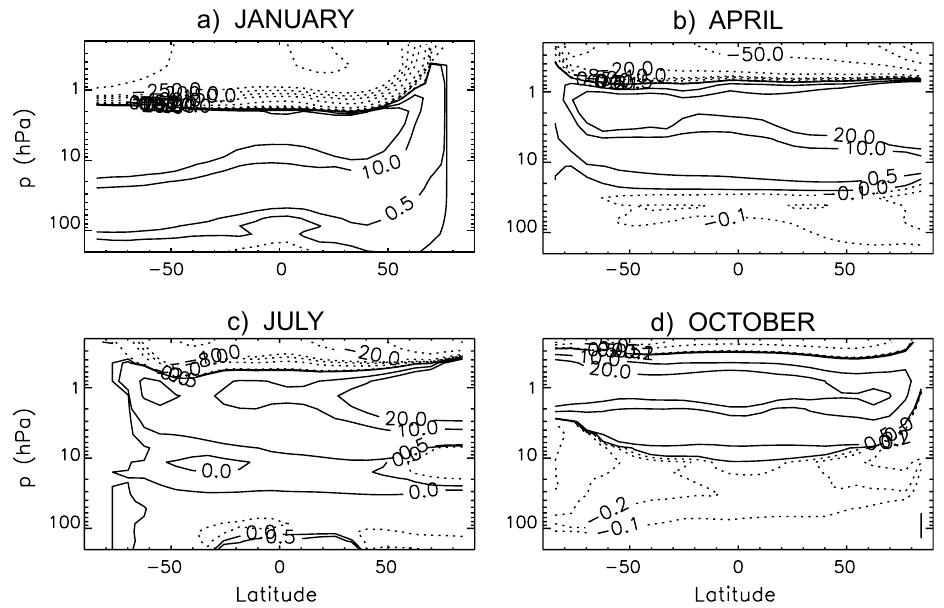
Fig. 3. Altitude–latitude distribution of the CoMeCAT loss tendency with [CH 4 ] (coefficient c 1 ) in units of (10 − 14 day − 1 ppmv − 1 ) for (a) January, (b) April, (c) July and (d) October. Solid contours indicate positive values; dashed contours indicate negative values.